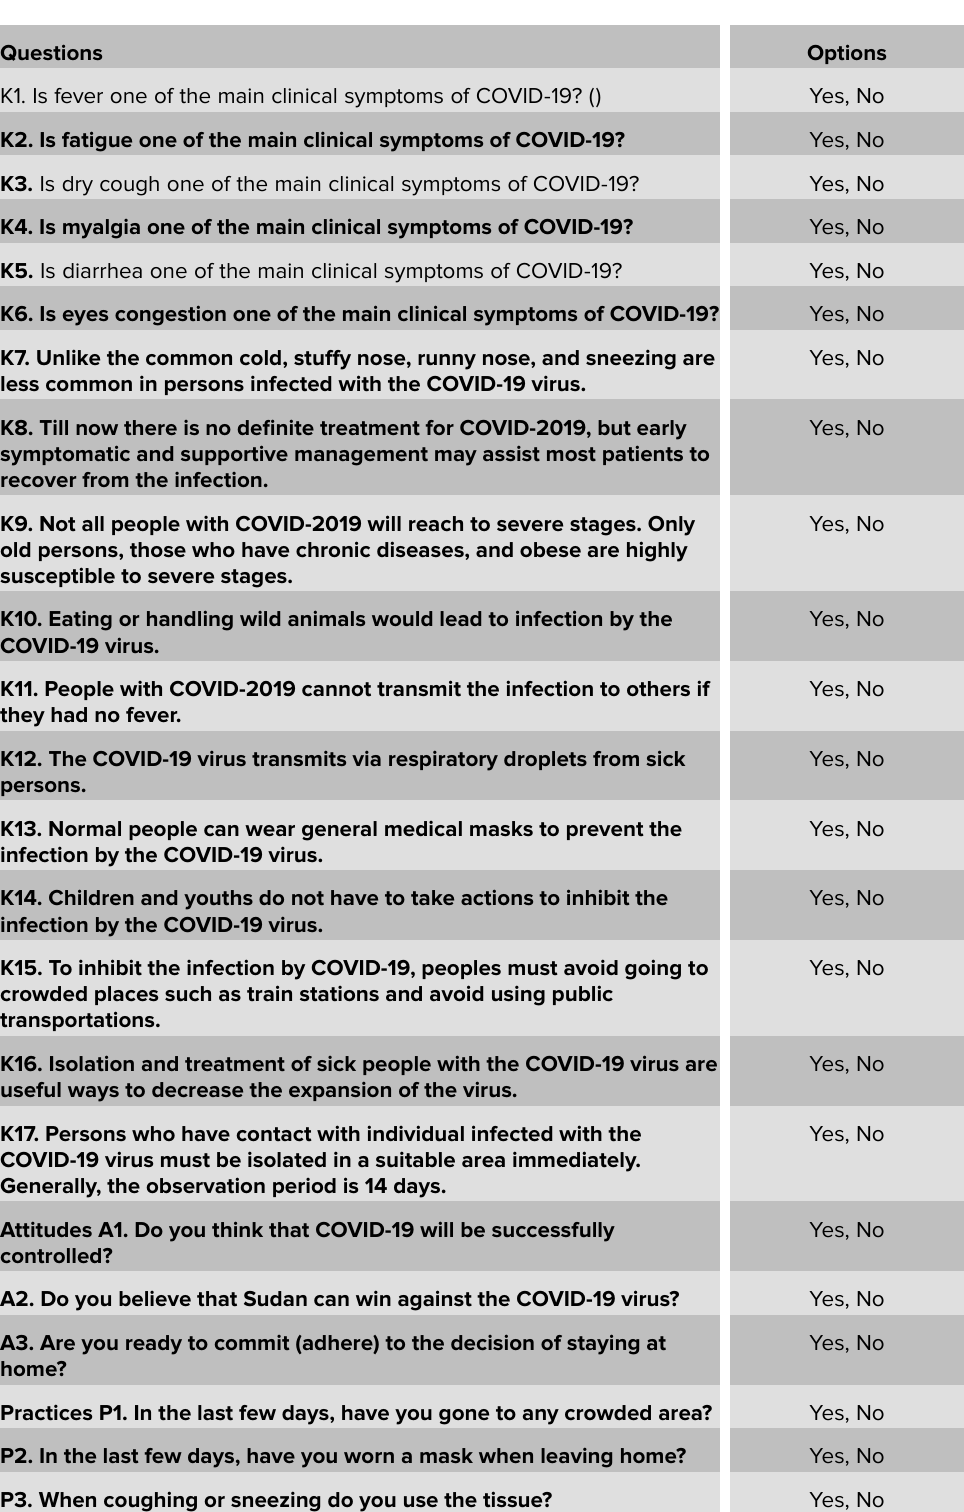
TABLE 1: Questionnaire of knowledge, attitudes, and practice towards